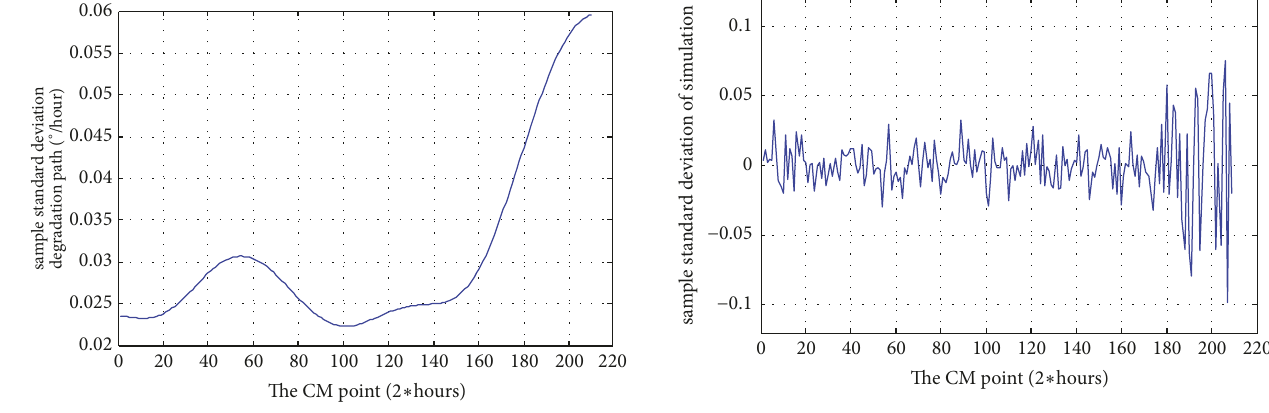
Figure 6: The trend items.